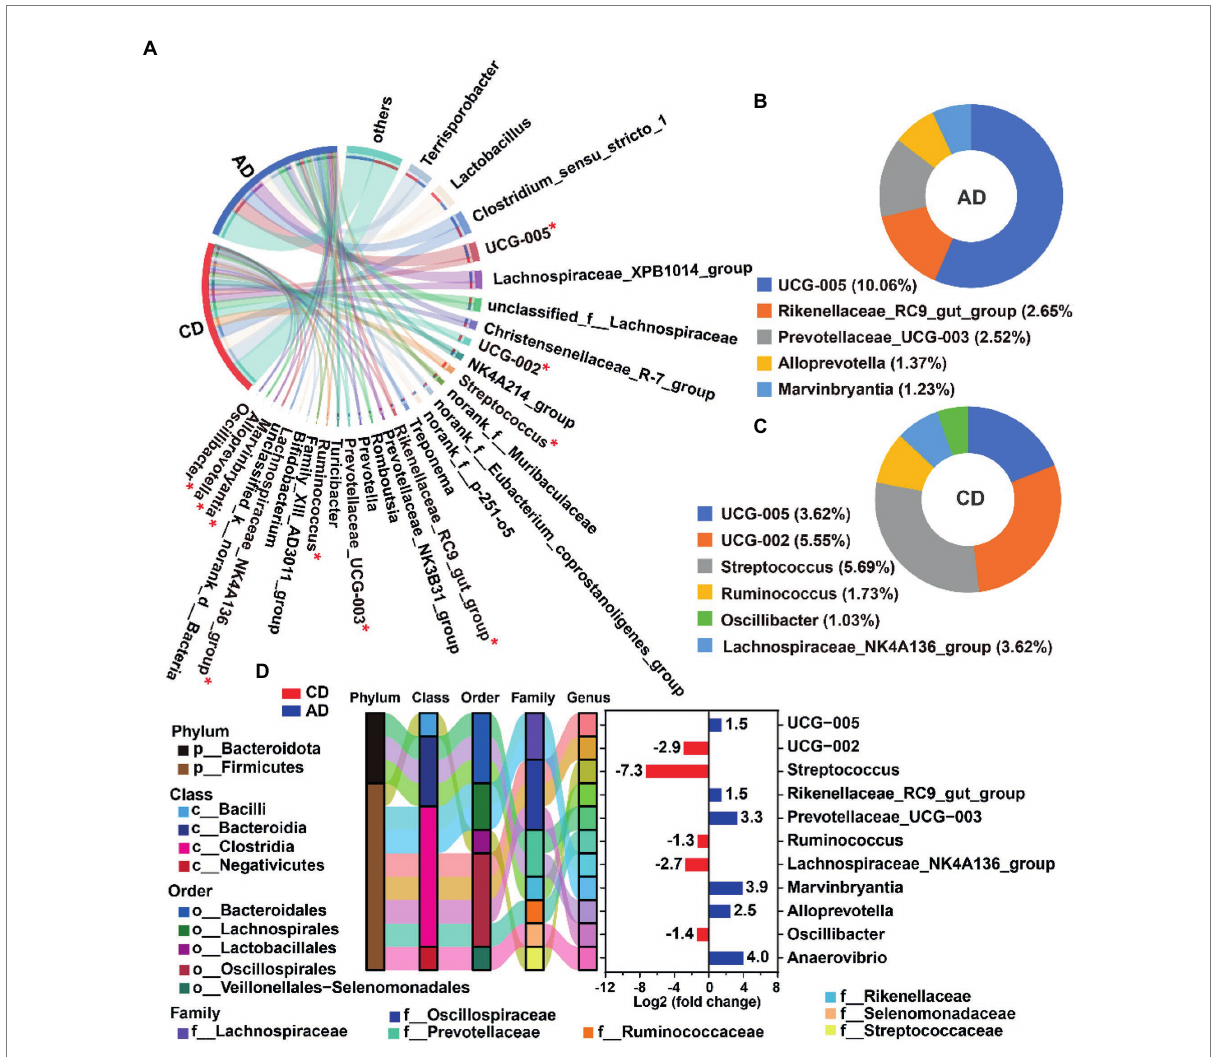
FIGURE 5 Differential genera analysis between CD and AD groups. The top 1% genera (including differentially abundance genera with FDR <0.05) from colon digesta of pigs in CD and AD group. (A) The enriched differential genera with relative abundance over 1% in AD group (B) and CD group (C) ; Taxonomy and differentially abundant genera (in the relative abundance of top 50) from colon digesta of pigs in AD group compared to CD group (D) . Positive values indicate that genera enriched in the AD group, while negative values suggest that genera enriched in the CD group. *Indicates FDR <0.05. CD, control diet; AD, alfalfa